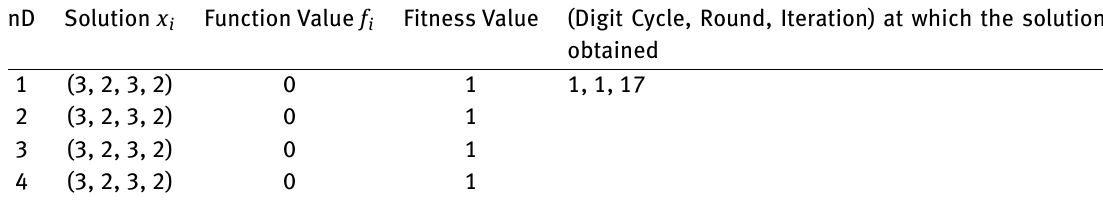
Table 22: Digit Cycle Results for Himmelblau’s function with 4 variables